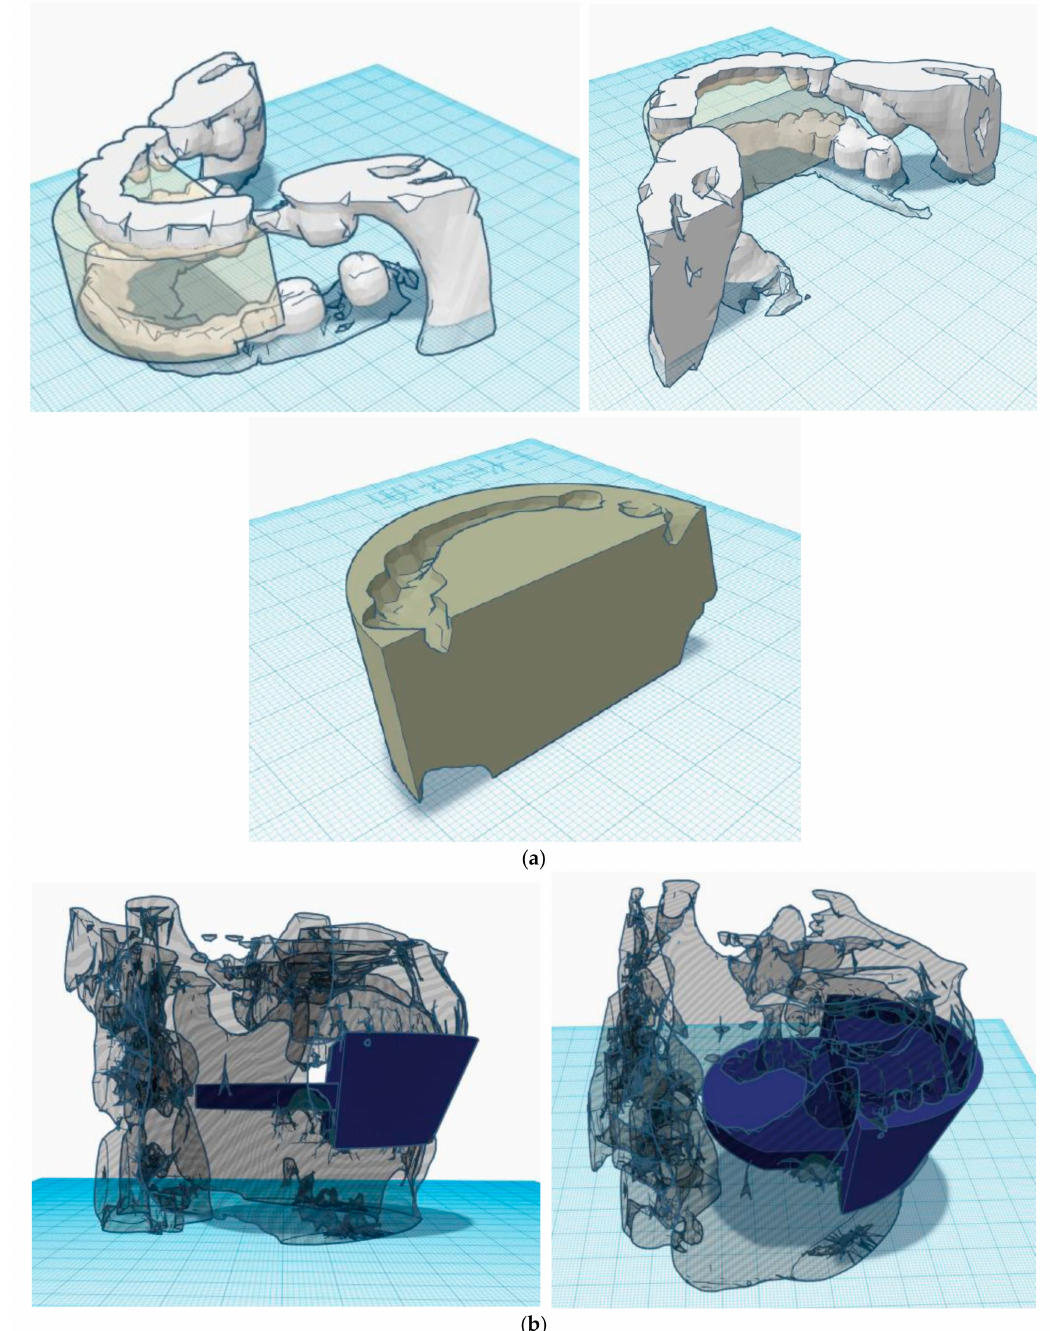
Figure 3. Blueprint for 3D printing. ( a ) The occlusal surface was contoured in the blueprint with incisors, canines, and molars well expressed. ( b ) The tongue depressor was designed to immobilize the tongue, and the length of the tongue depressor was adjusted to prevent occurrence of the gag reflex caused by over-extension of the tongue